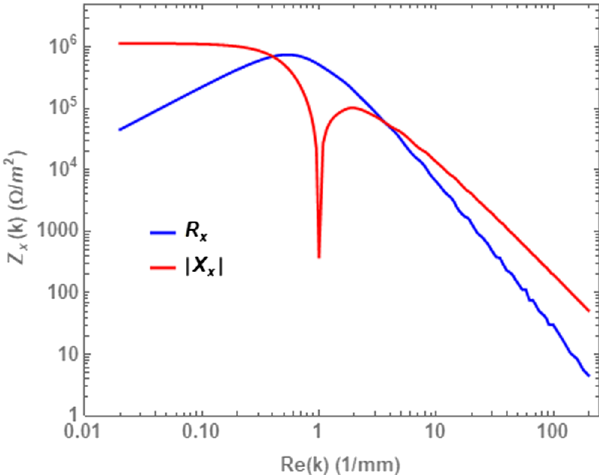
FIG. 30. The real R and absolute value of the imaginary x j X x j parts of the transverse impedance of the mid cell of the XARA structure as calculated by the numerical CFD code for Im ð k Þ ¼ 0 . 5 mm − 1 .